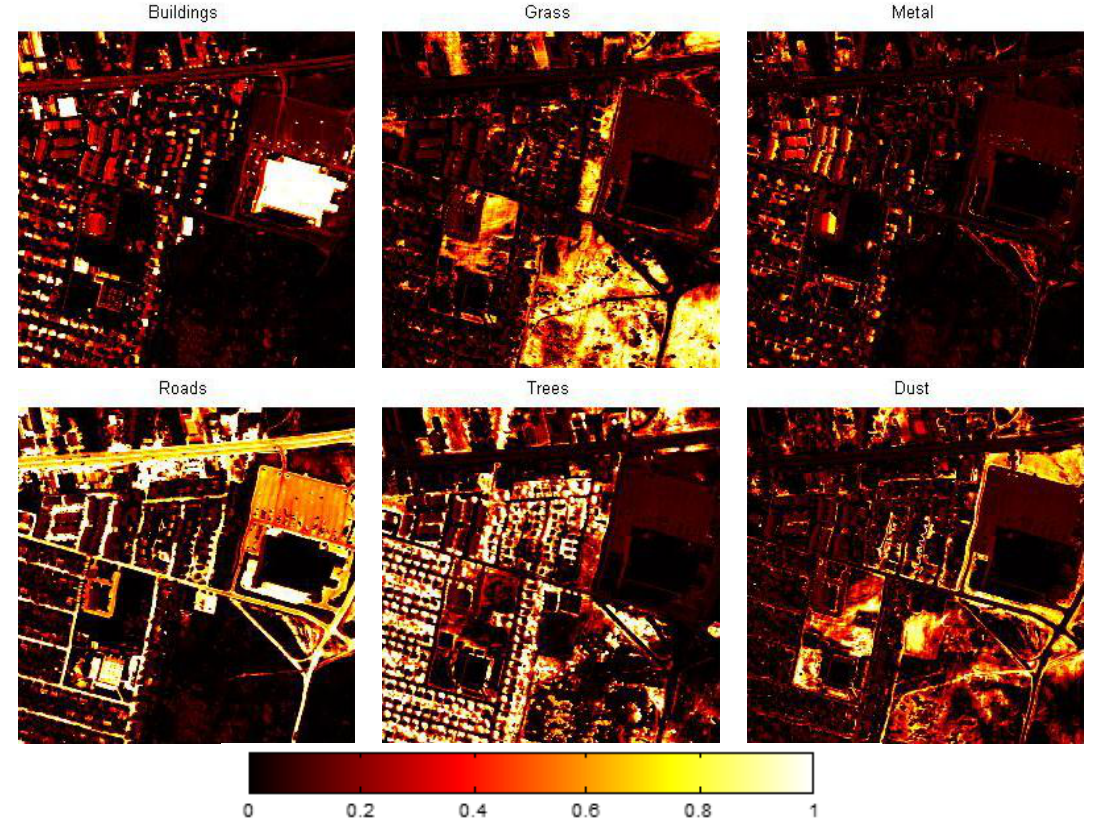
Figure 8. The proportion of each material in the urban